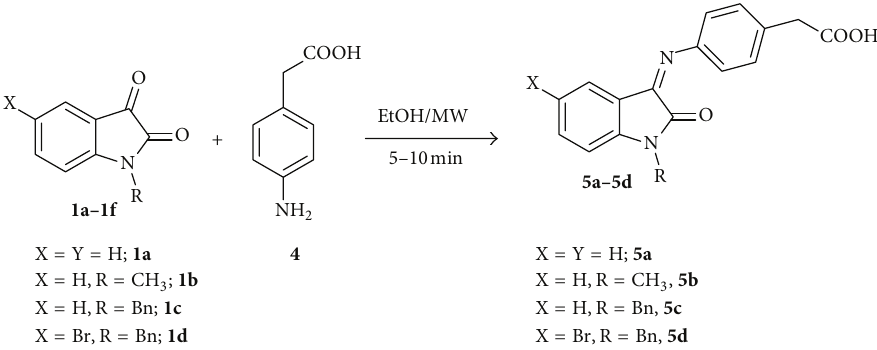
Scheme 2: Synthesis of isatin-3-iminocarboxylic acid